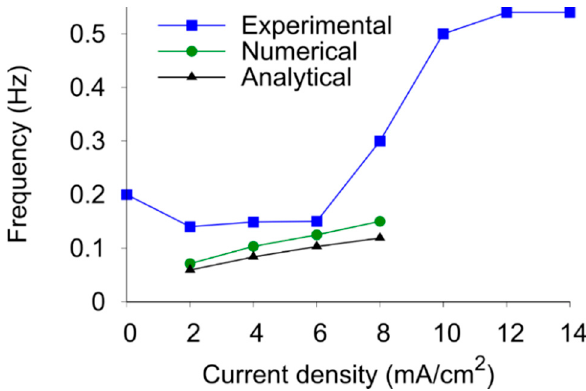
Figure 14. Experimental, numerical, and analytical results of the oscillation frequency as a function of the current density.